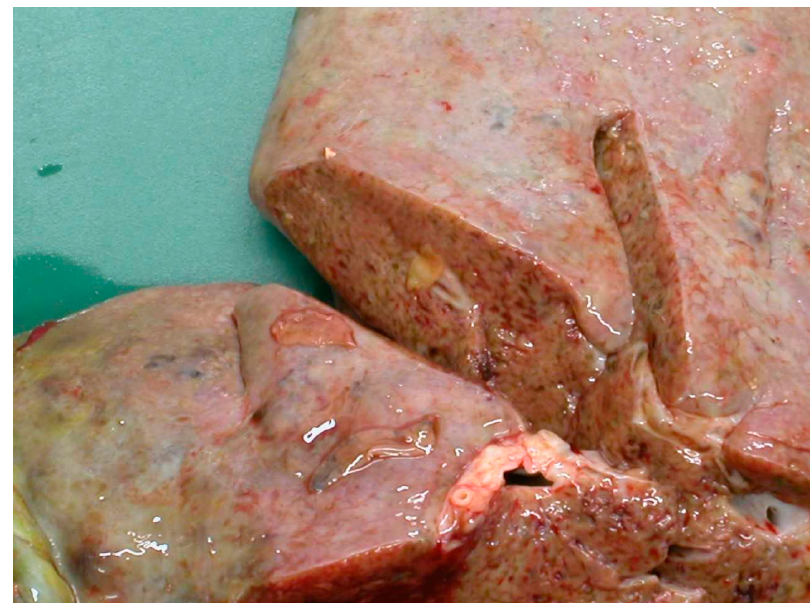
Figure 3. Hepatic damage caused by the migration of the juvenile flukes.